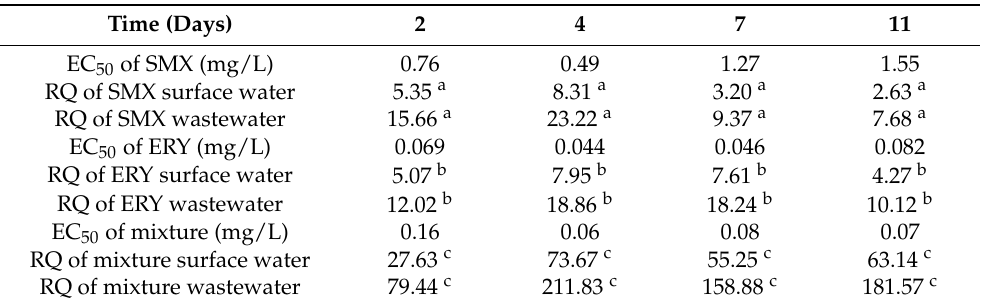
Table 1. Effective concentration (EC 50 ) and risk quotients of SMX, SMZ, and their mixture (SMX: ERY = 10:1) for R. subcapitata.